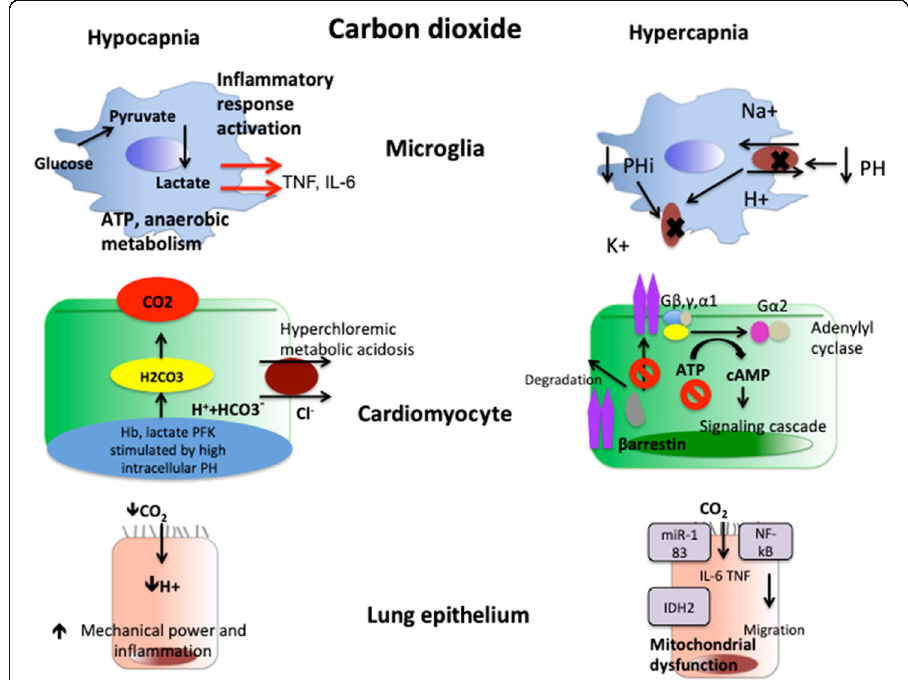
Fig. 3 Effect of carbon dioxide on microglia, cardiomyocytes, and lung epithelial cells. Microglia: hypercapnia decreases extracellular pH and intracellular pH (Phi). Increased Phi increases firing rate of CO 2 / H 2 chemosensitive neurons, by an oxidant-induced decrease in K+ conductance. Hypocapnia with cerebral vasoconstriction and ischemic insult shifts the anaerobic metabolism and activates local and systemic inflammatory response. Cardiomyocytes: hypercapnia and acidosis reduce the sensitivity of the adrenergic receptor and expression. Hypocapnia has effect on intracellular buffers (mostly hemoglobin within red blood cells) determining release of hydrogen. Hydrogen combines with bicarbonate to form carbonic